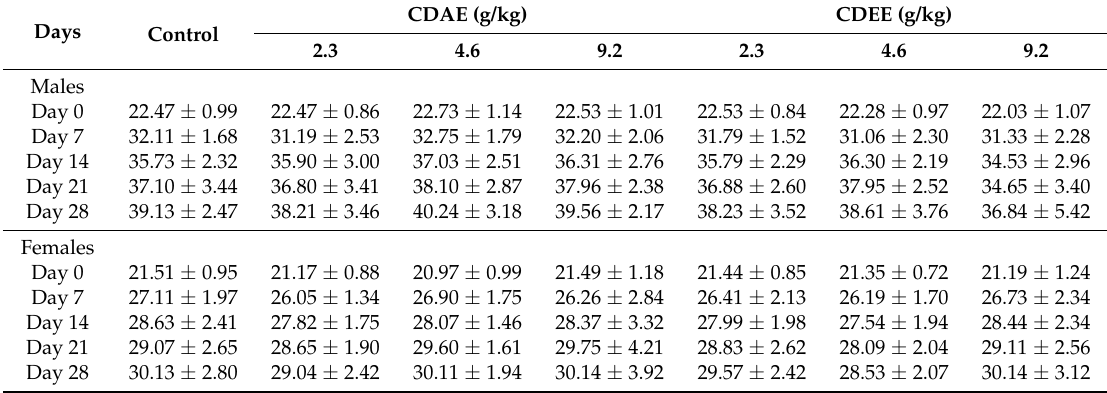
Table 1. Effects of oral administration of CDAE and CDEE on body weights in